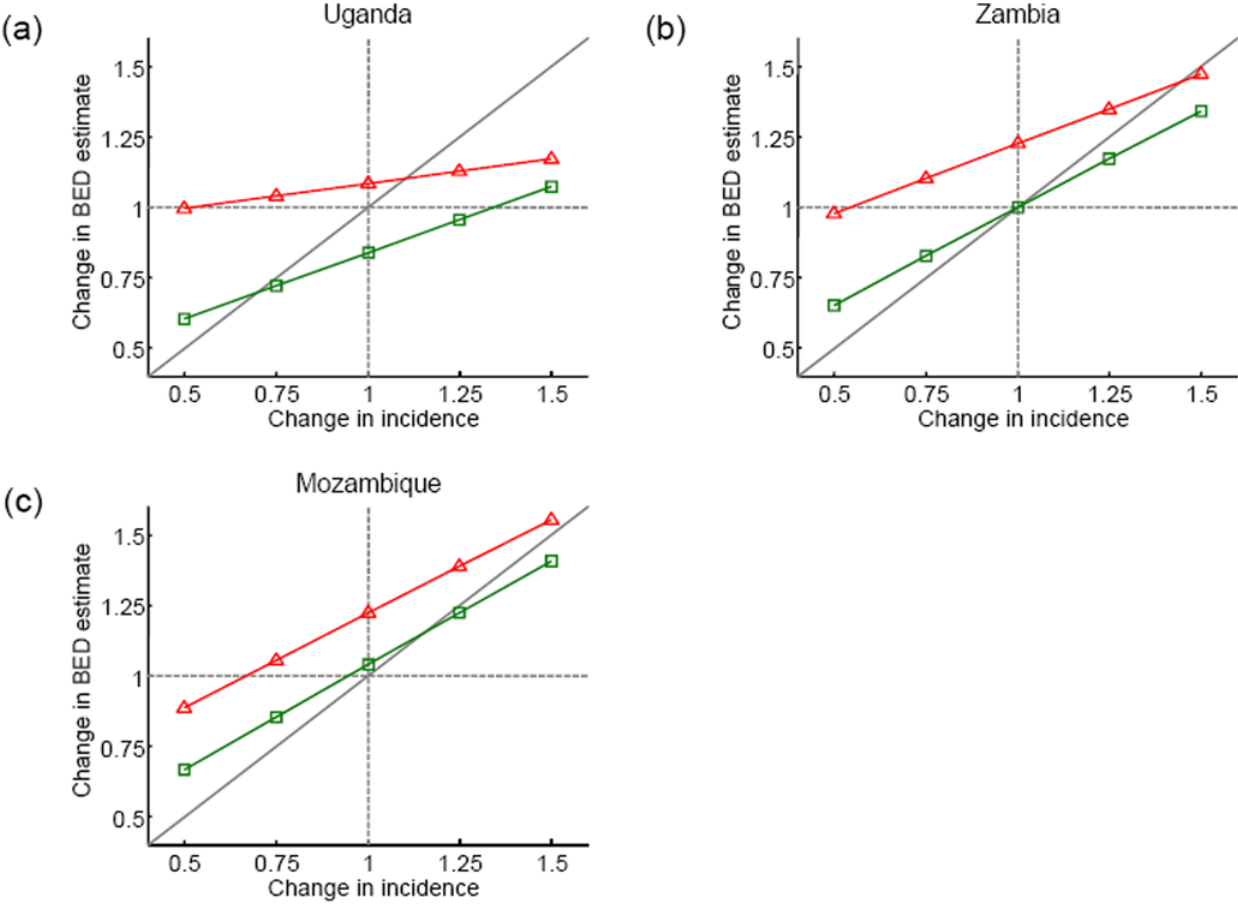
Figure 4. The ability of the BED test to detect changes in incidence. The incidence change estimated in 2006 five years after an instantaneous change in incidence by a factor 0.5, 0.75, 1.0, 1.25 or 1.5 (i.e. decreased by half, decreased by a quarter, no change, increased by a quarter, increased by half), using the alternative BED response scenarios: scenario A (stable proportion false positive: green squares); and, scenario B (increasing proportion false positive: red triangles). The analysis is repeated for incidence patterns representative of Uganda ( a ); Zambia ( b ); and, Mozambique ( c ). Note that a factor of 1.0 indicates no change in incidence. The thick diagonal grey line shows the 1:1 relationship expected if the BED estimate perfectly tracks changes in